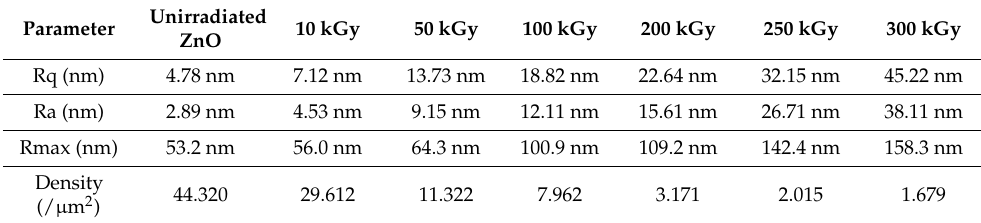
Table 2. Microstructural analysis of MgZnO roughness and particle density.